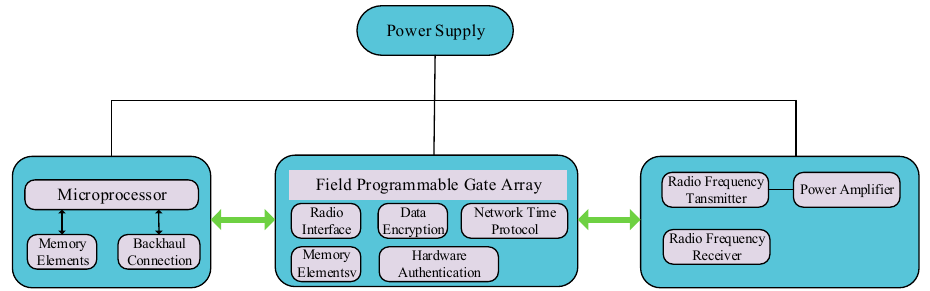
Figure 1. A hardware composition model of a typical SBS.